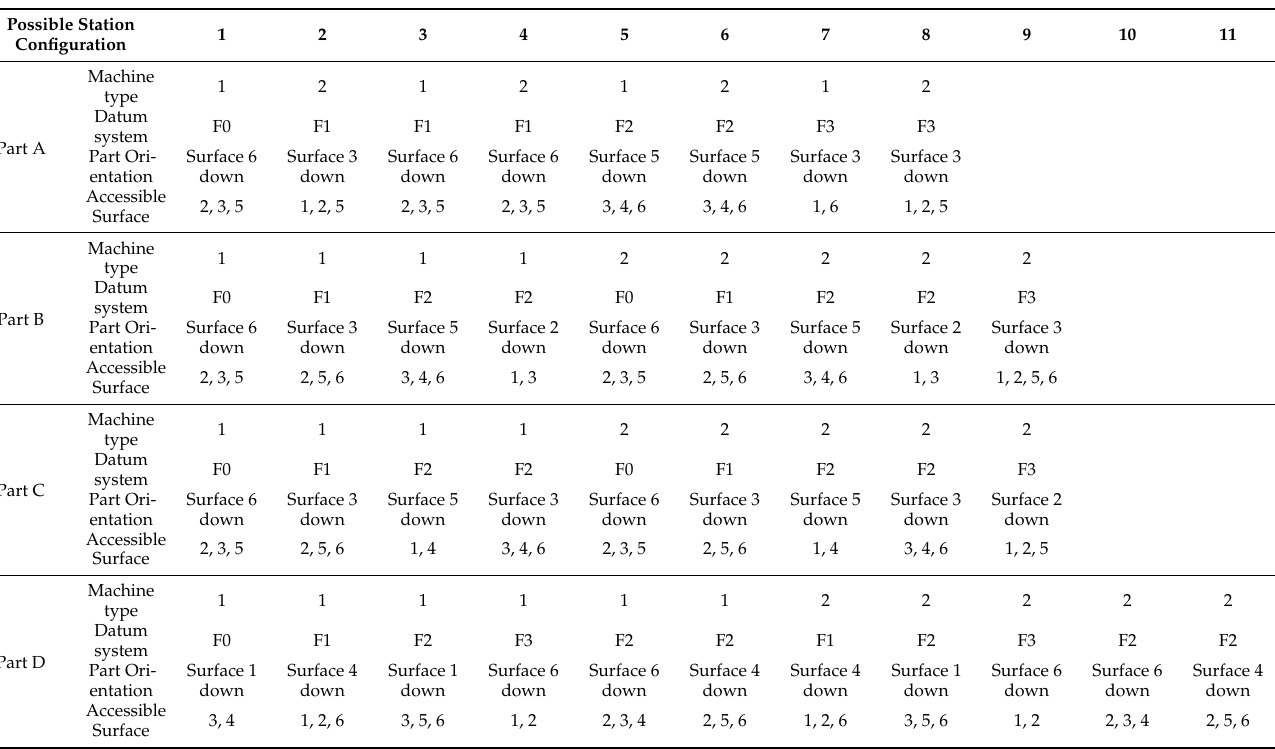
Table A4. Possible station configurations for the four